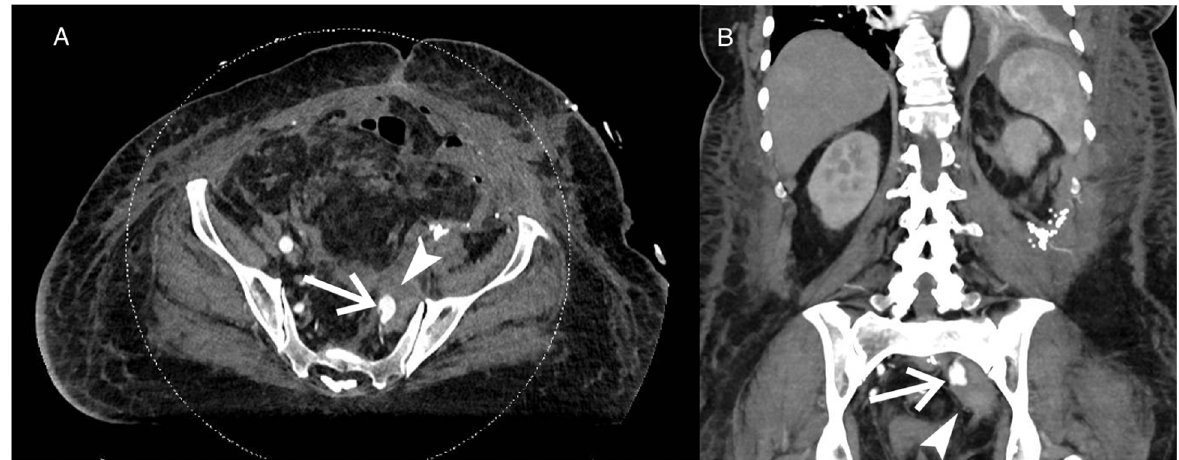
Fig. 1 Initial CT angiogram of the left internal iliac artery mycotic pseudoaneurysm. A ) Axial CT image and B ) MPR coronal CT image shows left internal iliac artery mycotic pseudoaneurysm measuring 3 6 cm(arrow) and adjacent inflammatory changes ×